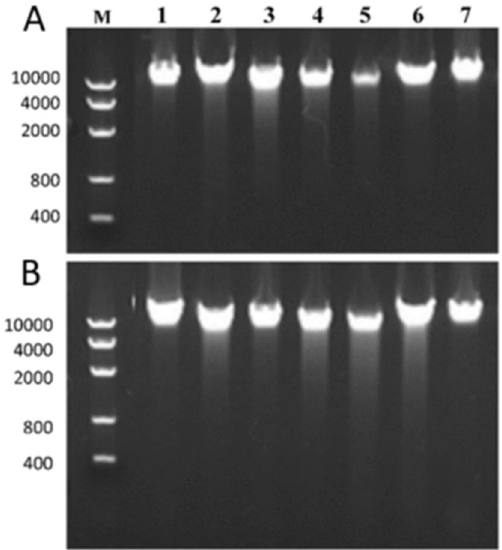
Figure 2. Comparative gel migration profiles from frozen ( A ) and corresponding dried ( B ) DNA which was extracted from 7 different tumor samples (1–7). M: Marker with the basepair length indicated next to the picture. DNA extracted from frozen tissue ( A ) as well as corresponding DNA extracted from encapsulated DNA ( B ) showed a strong band at high molecular weight for all 7 tumor samples indicating the presence of non-degraded, high quality DNA.